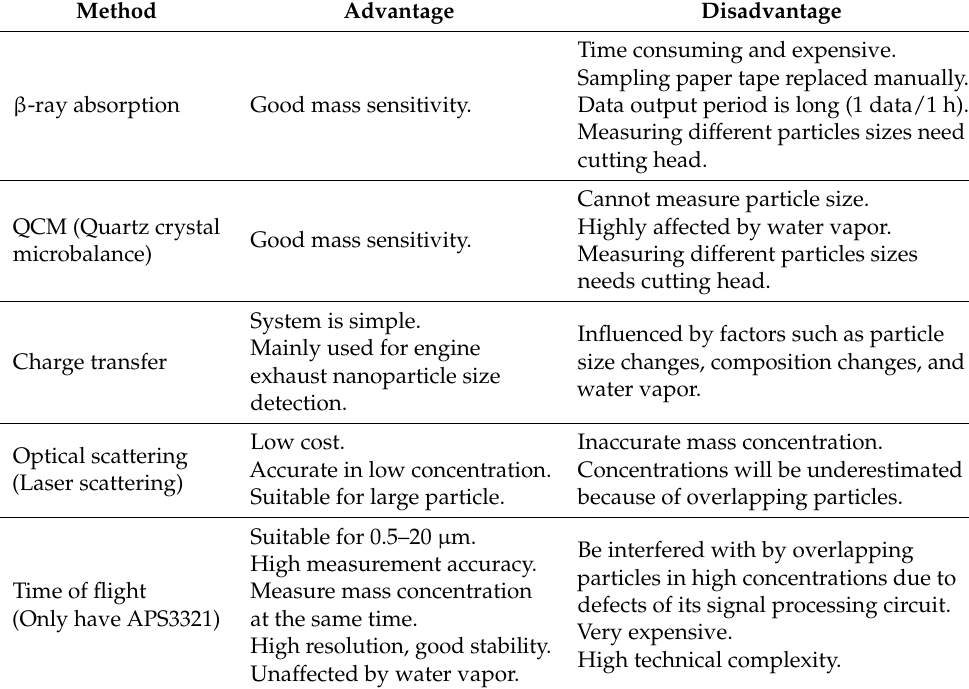
Table 1. Methods for measuring particulate concentration and